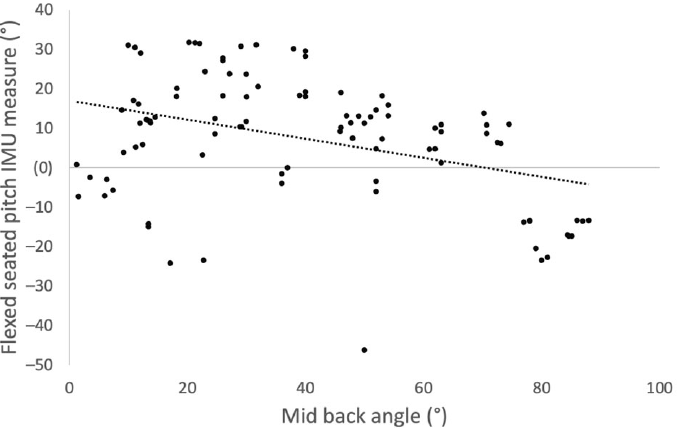
Figure 4. Scatter plot showing correlation between mid-back angle and change in pitch measured by the IMU device when the participants moved into the flexed seated position from standing.